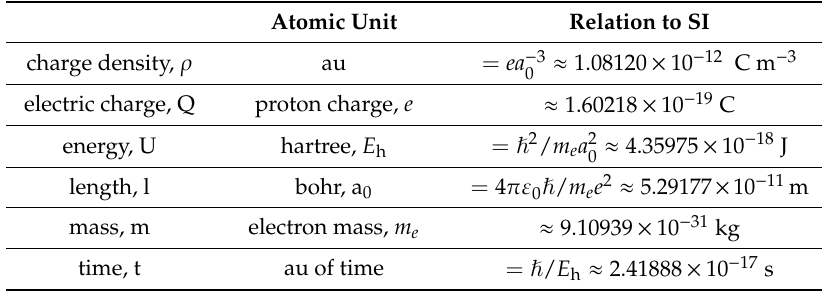
Table A1. Atomic units used in this work and their relation to SI units: [120]. Atomic